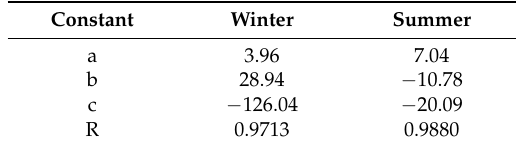
Table 3. Details of constants and correlation coefficients for the effective power curve.